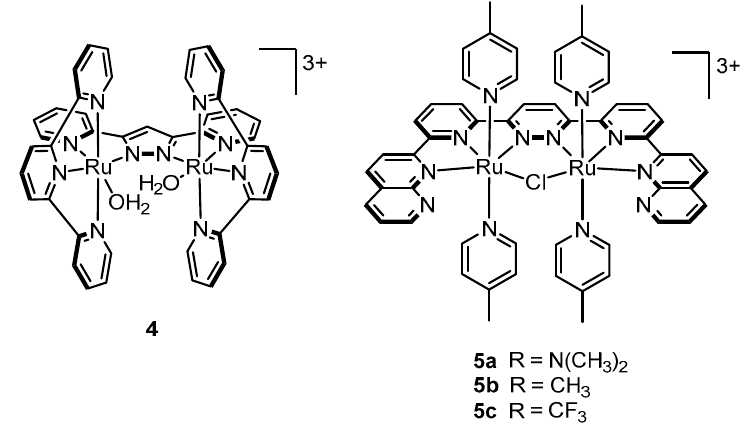
Figure 5. Dinuclear catalysts reported by Llobet’s ( 4 ) and Thummel’s groups ( 5a – c ).